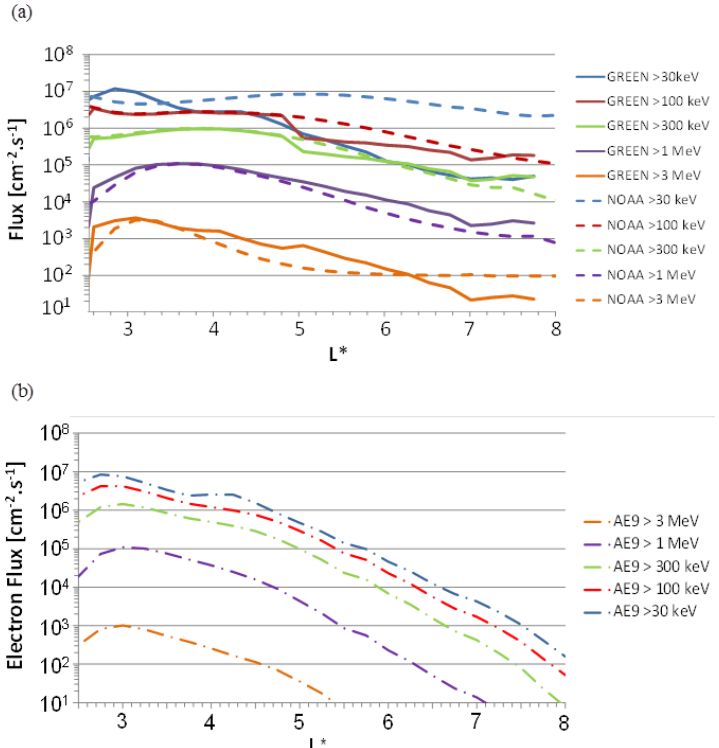
Figure 16. (a) Mean electron fluxes in LEO orbit between 1999 and 2010 from NOAA-POES measurements (in dashed lines) and from one solar cycle in GREEN- e (in full lines) for several energy channels. (b) Electron fluxes in LEO orbit (820km, 98 ◦ ) from AE9 v1.5